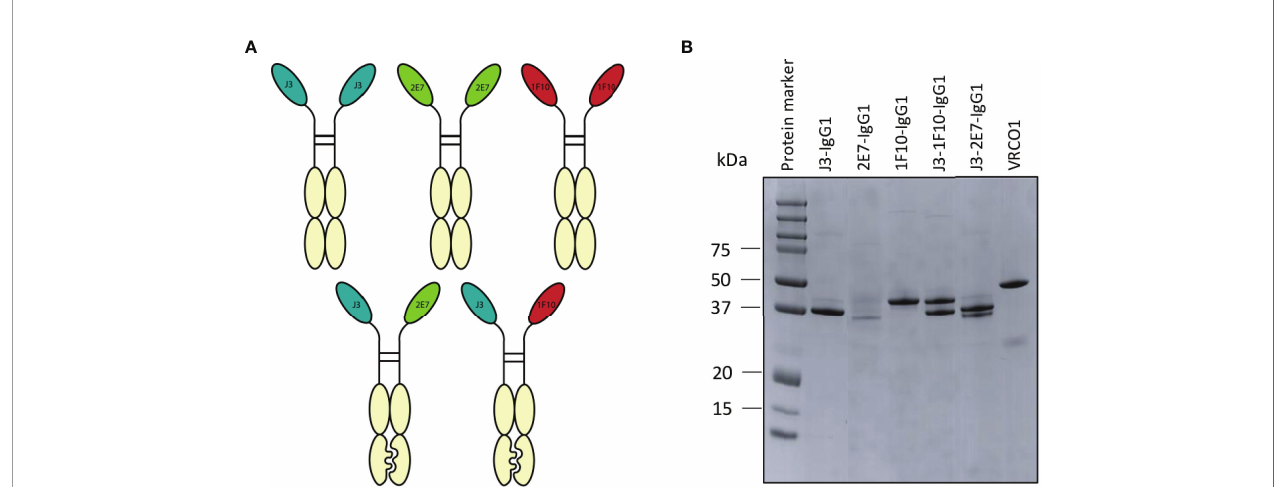
FIGURE 4 | Creation of nanobody-IgG1 constructs and their ability to bind to their target epitope. (A) Representation of the different nanobody-IgG1 constructs. 2E7, 1F10 and J3 fused to an human IgG1 heavy chain, lacking the CH1 domain and the bispeci fi c J3-1F10 and J3-2E7 antibodies containing the S354C, T366W,